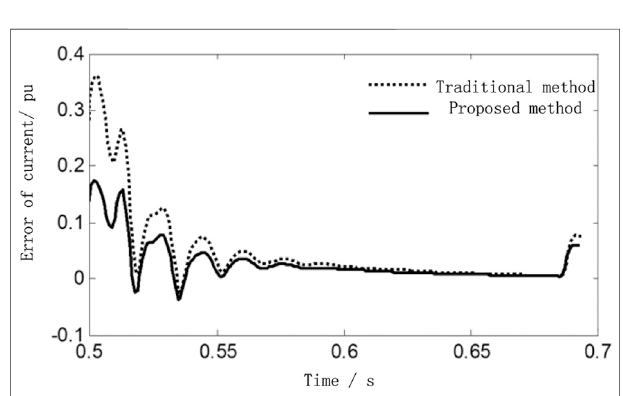
FIGURE 9 | Short circuit current error comparison between the traditional method and proposed method.